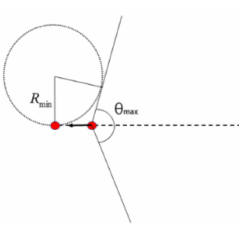
Figure 2. The maximum collision avoidance angle of the